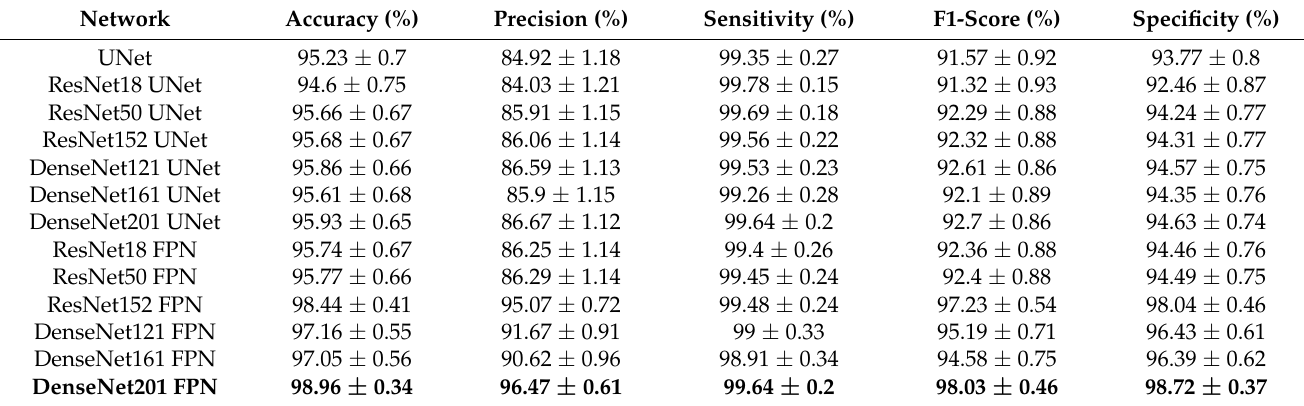
Figure 6. CT image (1st row), ground truth (2nd row), and the lesion segmentation of the best network (row 3) is shown in red. Table 7. The detection performance of the lesion segmentation network (Best results are formatted in Bold). Network Accuracy (%) Precision (%) Sensitivity (%) F1-Score